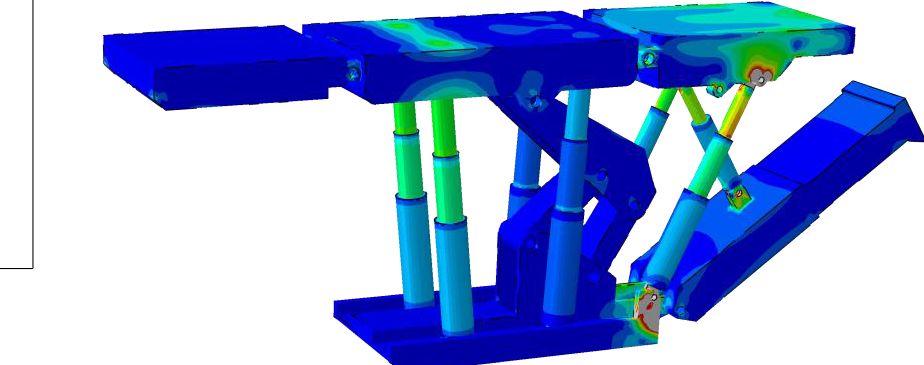
Figure 10. Stress of the whole support.